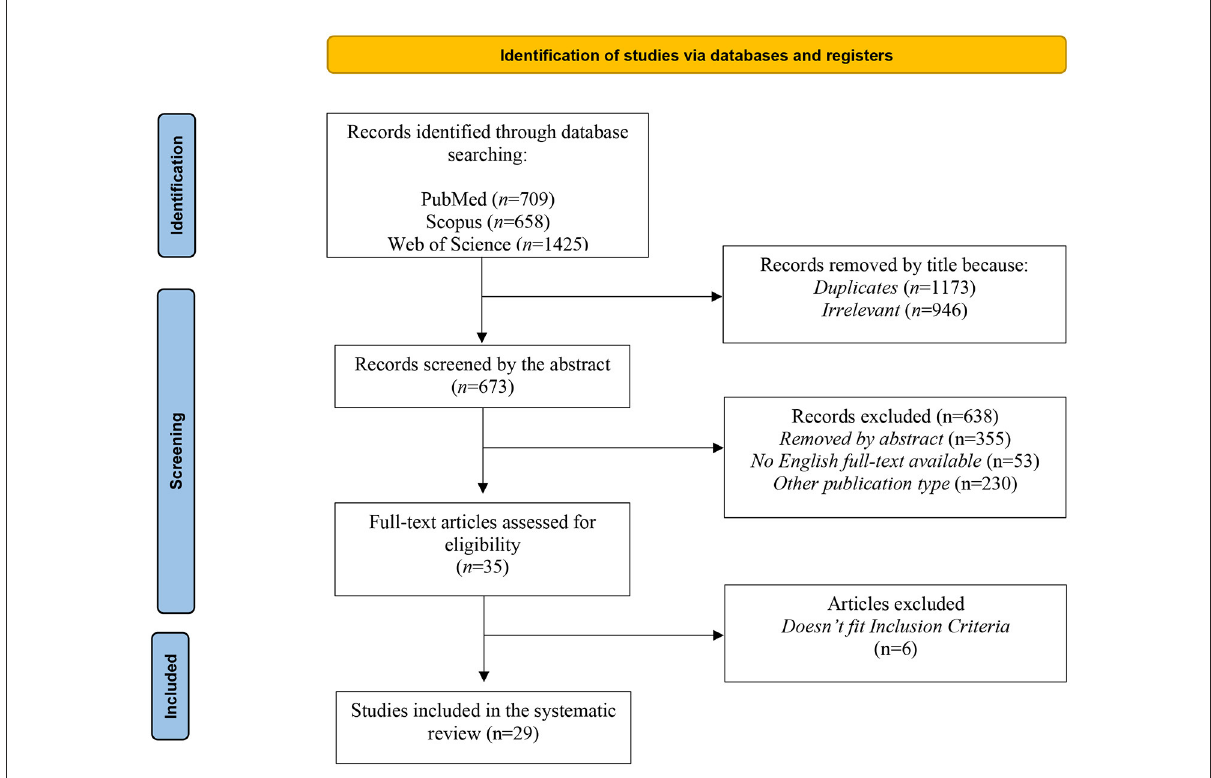
FIGURE1 PRISMA flowchart of the study selection process. PRISMA, Preferred reporting items for systematic reviews and